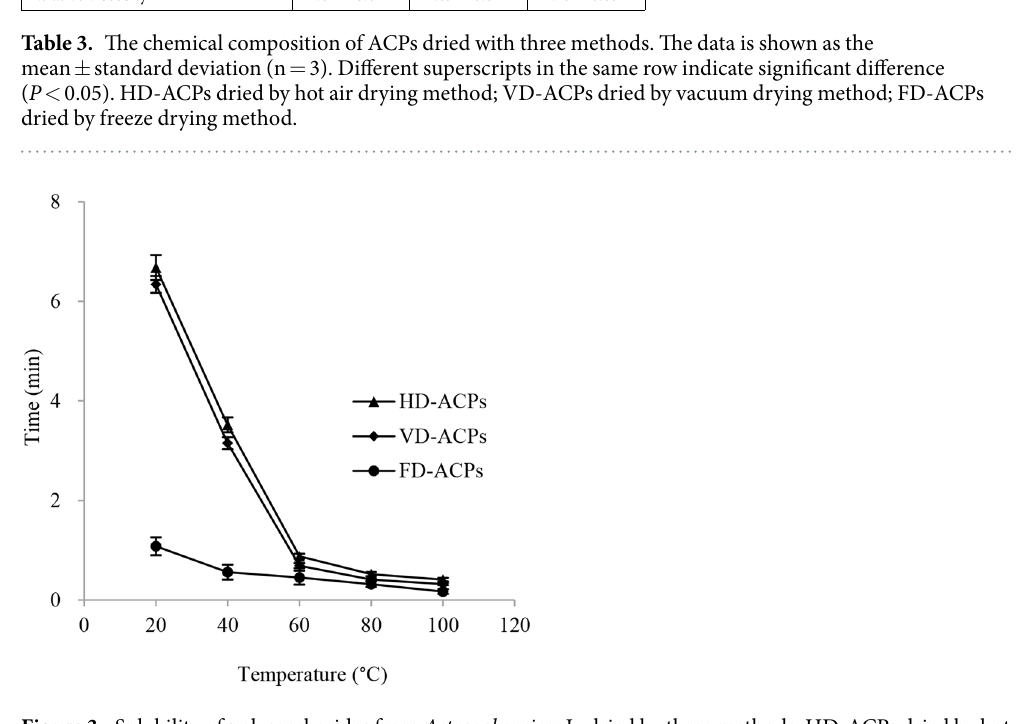
Figure 3. Solubility of polysaccharides from Astragalus cicer L. dried by three methods: HD-ACPs dried by hot air drying method; VD-ACPs dried by vacuum drying method; FD-ACPs dried by freeze drying